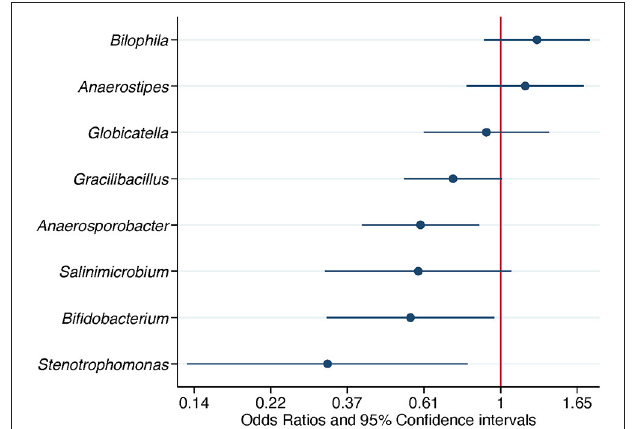
FIGURE 5 | Association of differentially abundant amplicon sequence variants (ASVs) with the isolation of Campylobacter . Odds ratios and 95% confidence intervals were obtained from a conditional logistic regression model and adjusted for flock age and sampling season. Differentially abundant ASVs were detected in composite litter samples. The classification at the genus level or at the family level if the former was not obtained, is shown for each ASV. Log scale was used in the